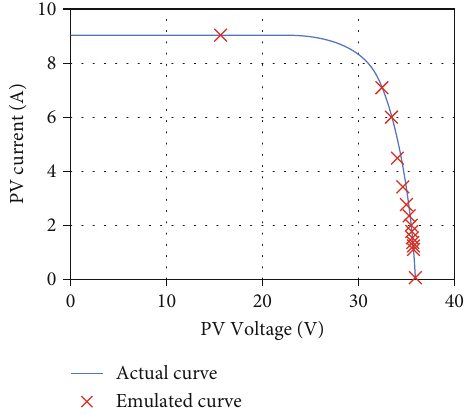
Figure 11: I-V characteristics for uniform irradiance